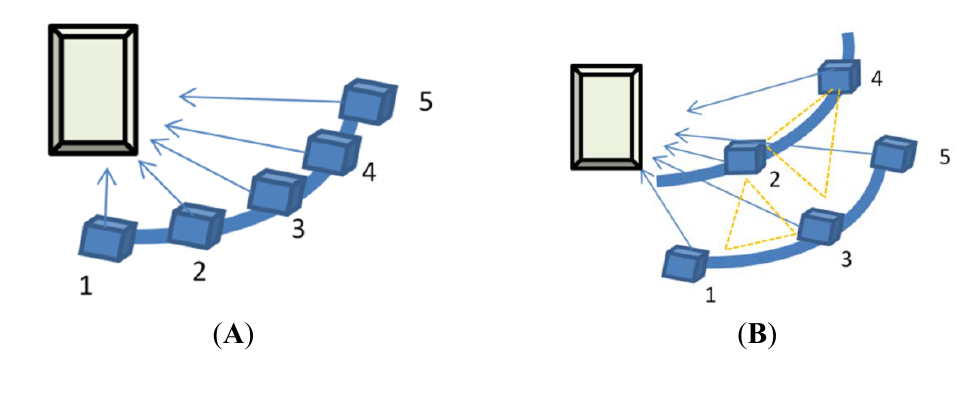
Figure 5. Adopted multi-camera frameworks. ( A ) The 1 × 5 Multi-Camera Configuration. ( B ) The 2 + 3 Multi-Camera